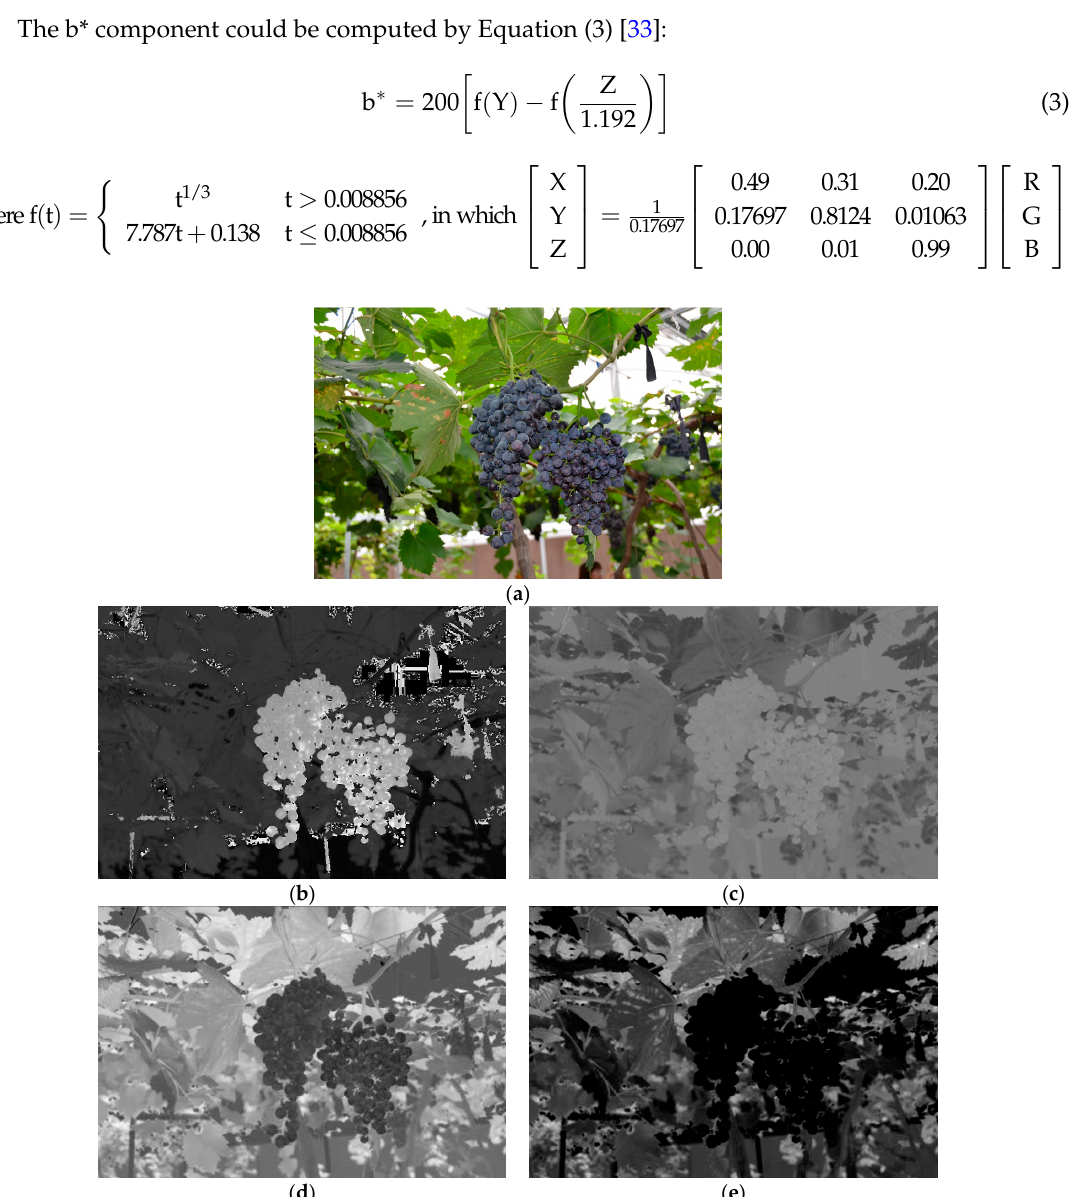
Figure 4. Several effective color components of images which can distinguish well the grape clusters from the background. ( a ) Original image; ( b ) H component image; ( c ) Cb component image; ( d ) b* component image; and ( e ) R-B component image.